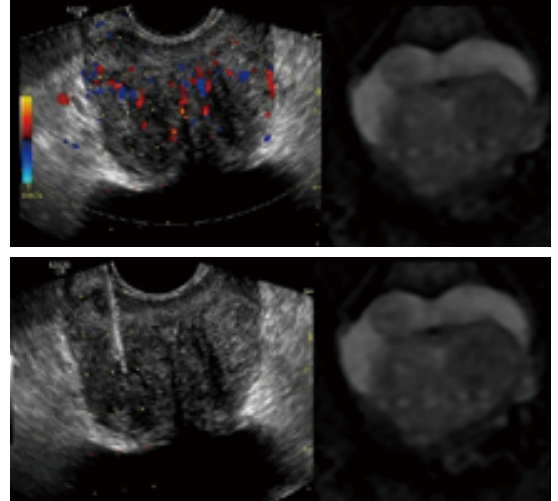
Figure 4 MRI-TRUS fusion image-guided biopsy combines the strengths of these two techniques which include the superior sensitivity of MRI for targeting suspicious lesions a the familiarity and practicality of